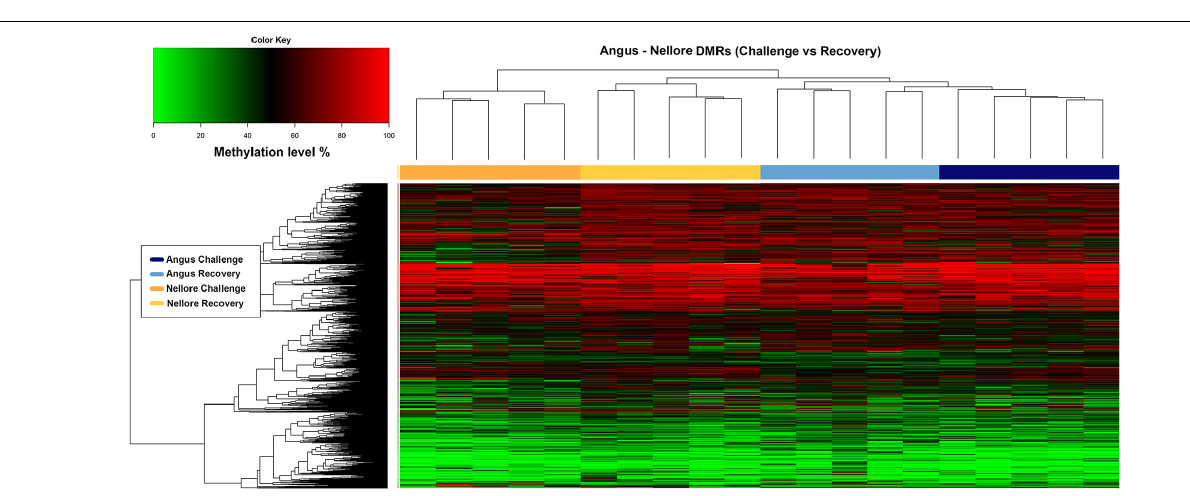
FIGURE 4 | Heatmap of methylation level (y axis) in Angus and Nellore populations (x axis) within 1967 DMRs. The blue and azure bars correspond to methylation level of Angus samples during challenge and recovery season and the orange and yellow bars correspond to methylation level of Nellore samples during challenge and recovery season